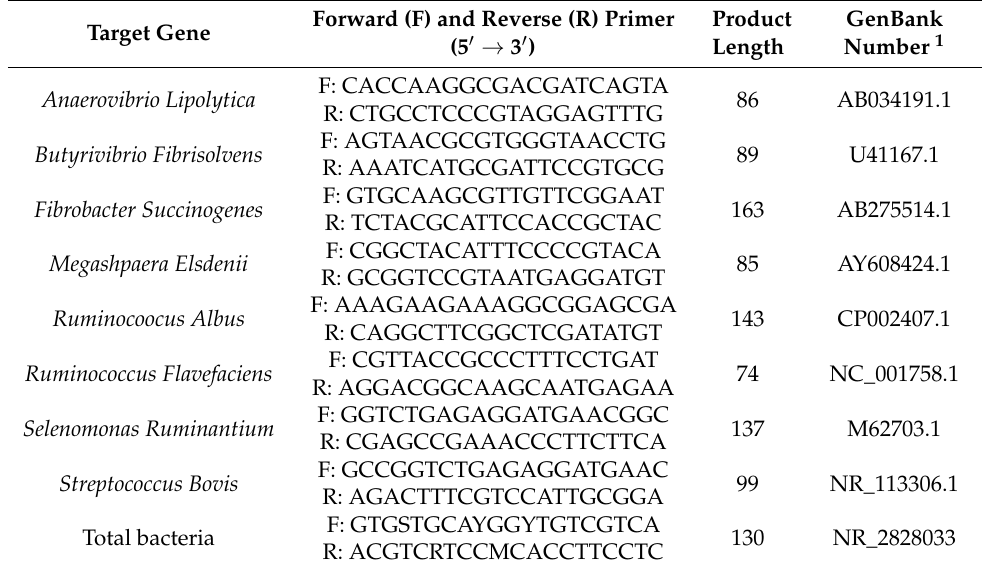
Table 2. Primer sequences of ruminal bacterial genes for RT- qPCR